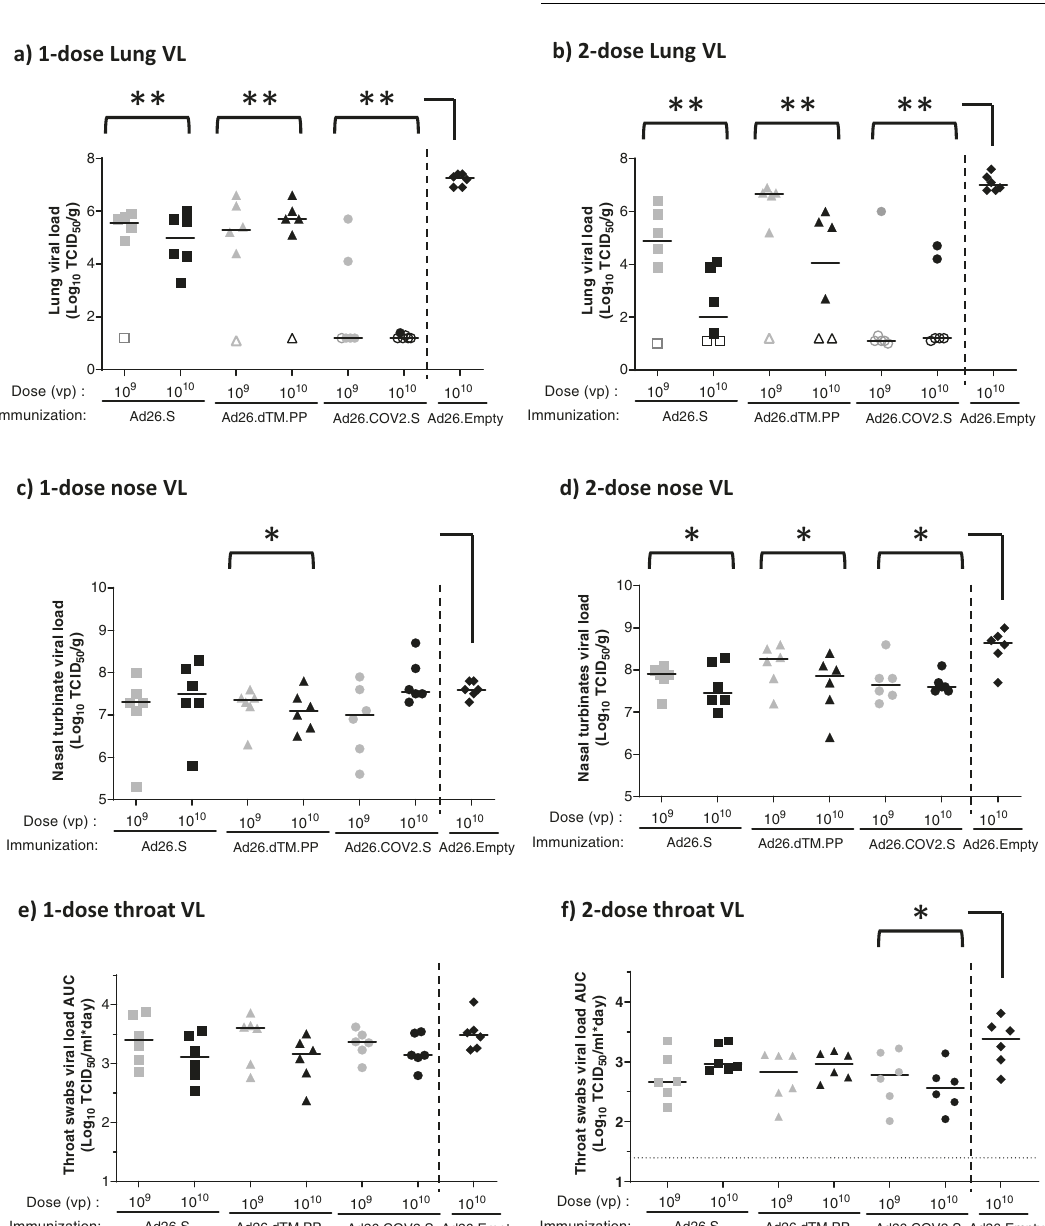
Fig. 3 Protection against SARS-CoV-2 viral replication in Syrian hamsters immunized with Ad26-based vaccines. Syrian hamsters were intramuscularly immunized with a one-dose regimen and a two-dose regimen of Ad26.S, Ad26.dTM.PP, Ad26.COV2.S, or Ad26.empty (Ad26 vector not encoding any SARS-CoV-2 antigens). Hamsters received an intranasal inoculation with 10 2 TCID 50 SARS-CoV-2 strain BetaCoV/ Munich/BavPat1/2020 4 weeks post-dose 1 (week 4) or 4 weeks post-dose 2 (week 8). a , b Right lung tissue and c , d right nasal turbinates were harvested at the end of the 4-day inoculation phase for viral load analysis. Replication-competent virus was measured by TCID 50 assay. e , f Throat swab samples were taken daily after inoculation, and viral load area under the curve during the 4-day follow-up was calculated as TCID 50 /mL × day. The median viral load per group is indicated with a horizontal line. LLOD was calculated per animal and animals with a response at or below the LLOD are shown as open symbols on the LLOD. Comparisons were performed between the Ad26.S, Ad26.dTM.PP, and Ad26.COV2.S groups across dose level, with the Ad26.empty group by Mann – Whitney U test. Statistical differences indicated by asterisks: * p < 0.05; ** p < 0.01. LLOD lower limit of detection, TCID 50 /g 50% tissue culture infective dose per gram tissue, TCID 50 /mL 50% tissue culture infective dose per mL sample, VP virus histopathology scores were overall consistent with viral load data, with lower median scores in the lungs of immunized groups compared with the Ad26.Emtpy group (Supp Fig. 4 and Supp Table 1) and no signi fi cant difference in the IHC and histopathol- ogy scores in nose tissues of vaccinated animals compared with the Ad26.empty control group independent of vaccine regimen (Supp Fig. 5 and Supp Table 1).